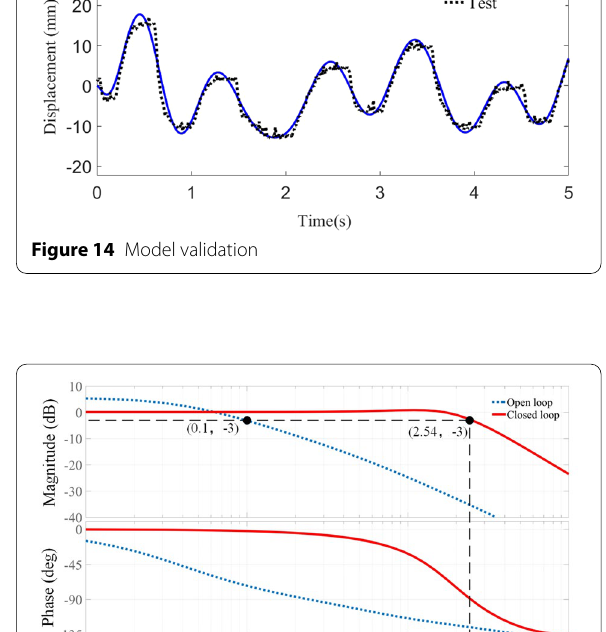
Figure 15 Frequency